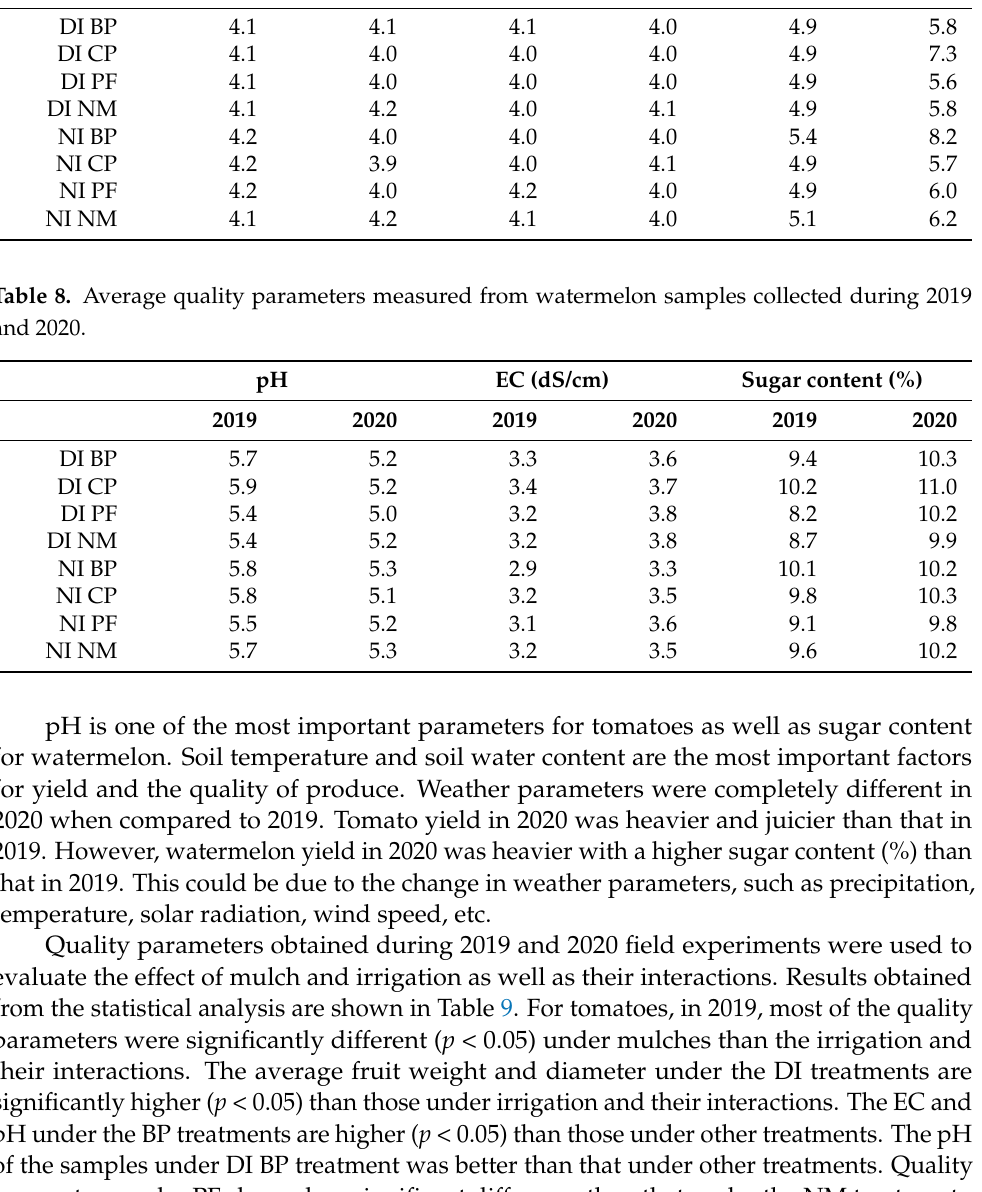
Table 7. Average quality parameters measured from tomato samples collected during 2019 and 2020. pH EC (mS/cm) Sugar Content (%)